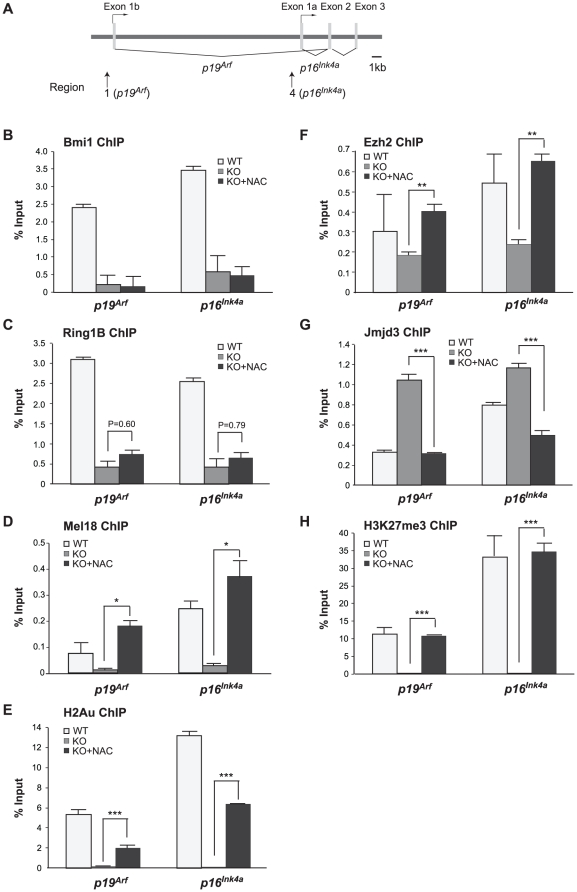
Zfp277 is required for the re-localization of PRC1, but not PRC2.
A. A schematic representation of the Ink4a/Arf locus in MEFs. ChIP assays were performed using anti-Bmi1, Ring1B, Mel18, H2AK119ub1, Ezh2, Jmjd3, and H3K27me3 antibodies. Regions amplified from the precipitated DNA by site-specific quantitative PCR are indicated by arrows. B–H. Q-ChIP analysis of the p19Arf exon 1b and p16Ink4a exon 1a. Wild-type MEFs and Zfp277
−/− MEFs at passage 2 with or without NAC treatment were subjected to ChIP analyses using the indicated antibodies. Percentages of input DNA are shown as the mean ± S.D. for multiple experiments (n>6). Statistical significance was determined with Student's t-test; **p<0.01, ***p<0.001.